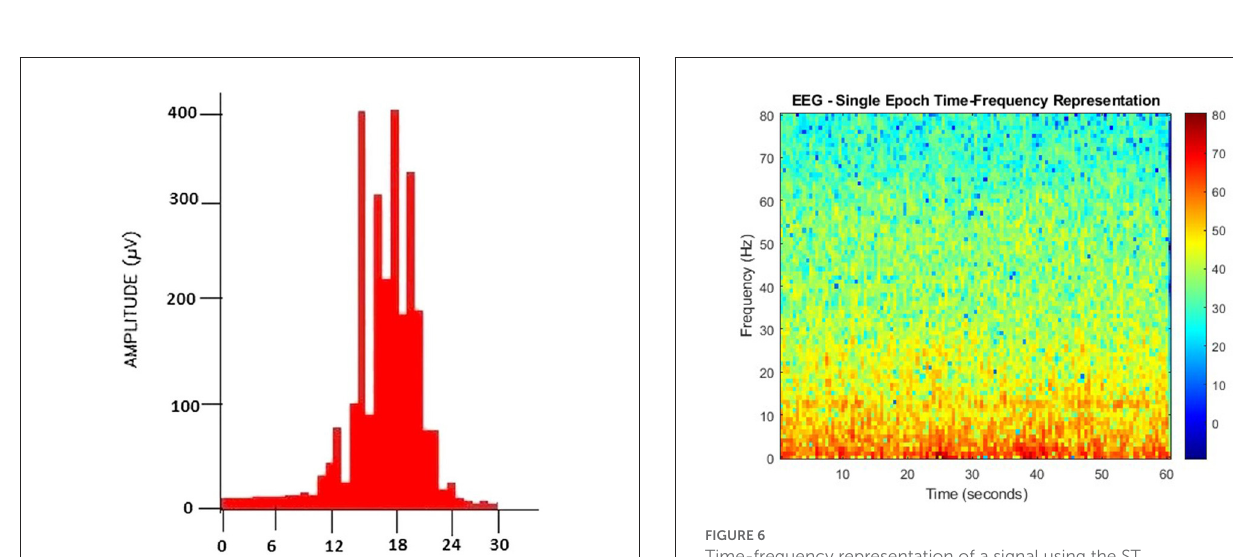
Algorithm 7. Band power (Mandel et al.,